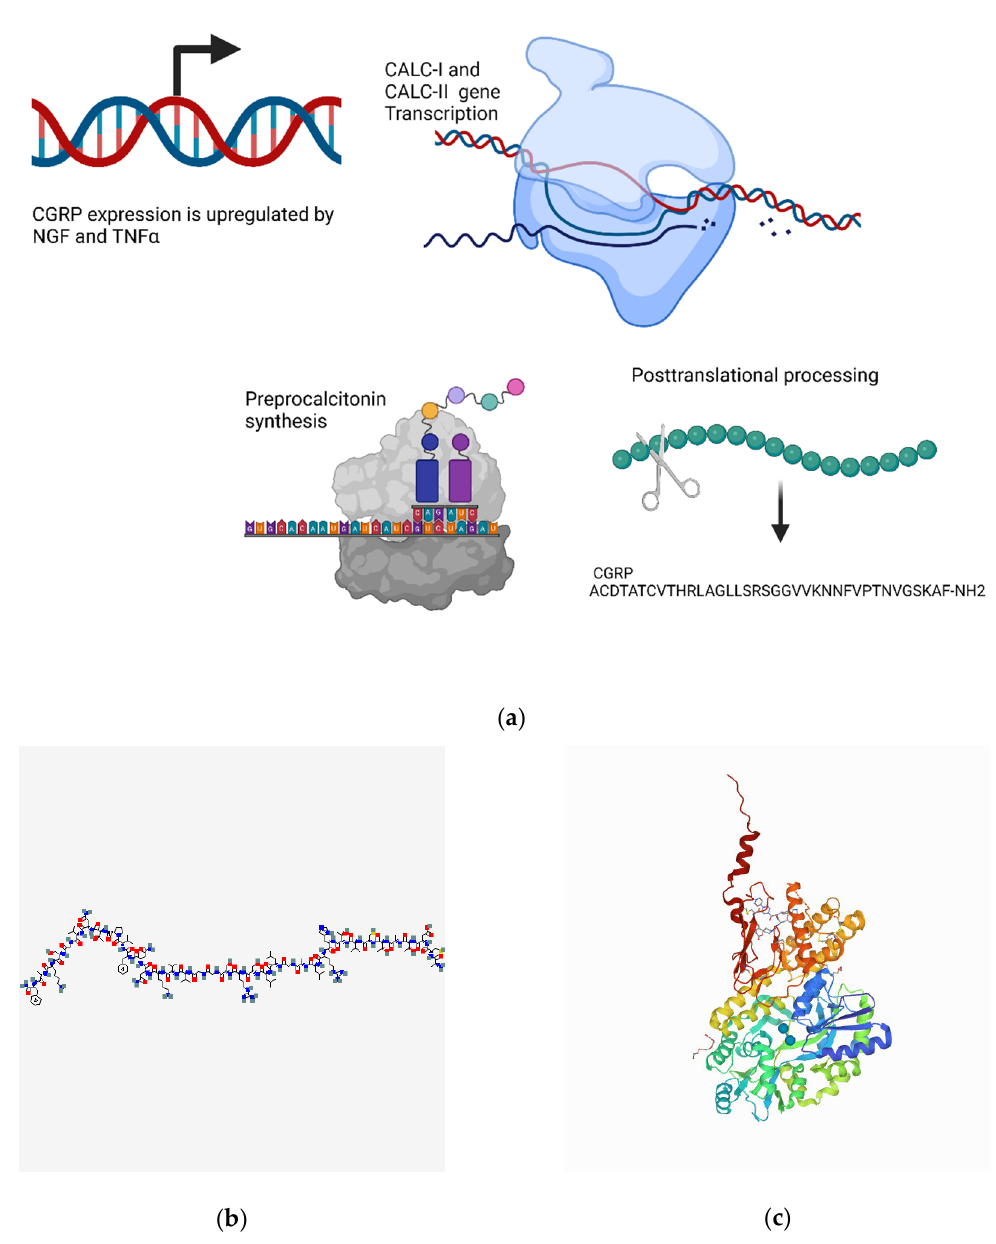
Figure 3. Neuropeptide CGRP and CLR receptor: ( a ) transcription and synthesis of CGRP (created with BioRender.com accessed on 22 October 2021); ( b ) 2D structure image of CGRP (https://pubchem.ncbi.nlm.nih.gov/compound/16132372#section=2D-Structure, accessed on 22 October 2021); ( c ) Crystal structure of a CGRP receptor ectodomain heterodimer with bound high-affinity inhibitor. Image from the RCSB PDB (rcsb.org) of PDB ID 6ZHO [309].